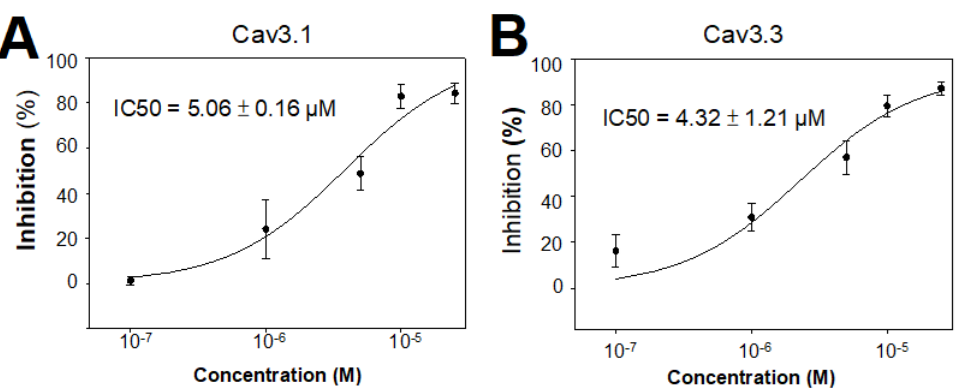
Figure 7. Concentration-response relationship for inhibition of Ca V 3.1 and Ca V 3.3 by ω -Avsp1a. Currents mediated by ( A ) Ca V 3.1 and ( B ) Ca V 3.3 expressed in HEK-293 cells were recorded before and after treatment with the indicated concentration of synthetic ω -Avsp1a. The IC 50 values were estimated by fitting a Hill Equation to the data.